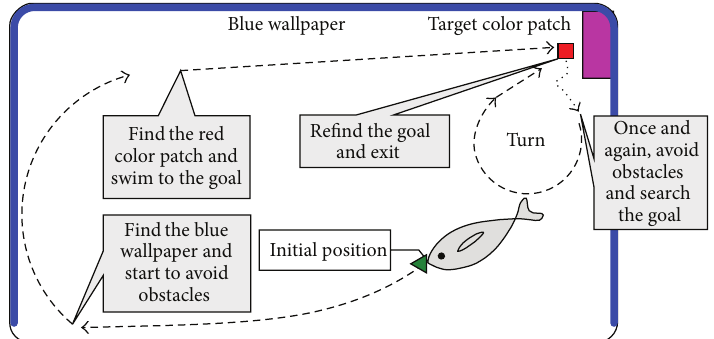
Figure 15: Schematic drawing of the moving trajectory correlating to Figure